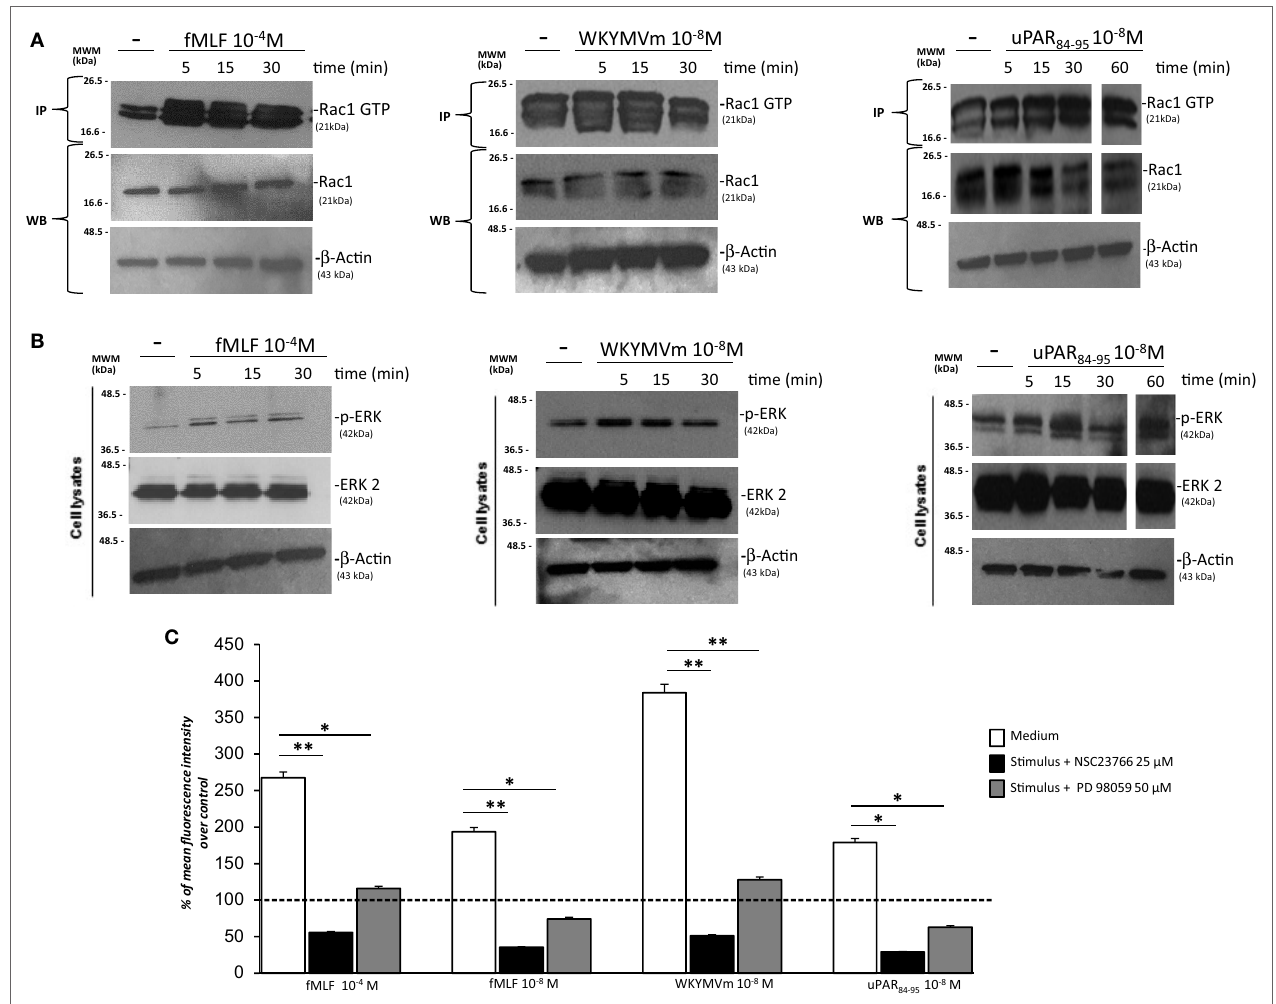
FigUre 4 | FPRs-mediated Rac1 and ERK activation in BJ cells. (a) BJ cells, treated with medium alone (-), N -formyl- l -methionyl- l -leucyl- l -phenylalanine (fMLF), WKYMVm peptide, or uPAR 84–95 peptide, were lysed and subjected to Rac1 activity assay using PAK-PBD-glutathione sepharose beads. Immunoprecipitates and the corresponding total lysates, as an input control, were subjected to Western blot analysis with an anti-Rac1-specific Ab and with an anti- β -actin Ab, as a loading control. (B) BJ cells, treated with medium alone, fMLF, WKYMV peptide, or uPAR 84–95 peptide were lysed and subjected to Western blot analysis with an anti phospho-ERK 1/2 (p-ERK)-specific Ab and then with anti ERK-2 and anti- β -actin Abs, as a loading control. (c) BJ cells were plated in a 96-well plate and treated with DCHF-DA. At the end of incubation, cells were treated with fMLF, WKYMVm peptide, and uPAR 84–95 peptide in the absence (white columns) or in the presence of NSC23766 (black columns) or PD98059 (gray columns). ROS release was measured as dichlorofluorescein (DCF) fluorescence intensity at 5 min. Results are expressed as a percentage of increase of mean fluorescence intensity of stimulated DCHF-DA-loaded cells in respect to unstimulated DCHF-DA-loaded cells (considered as 100%). Values are the mean ± SEM of three experiments performed in triplicate. * p < 0.05; ** p <